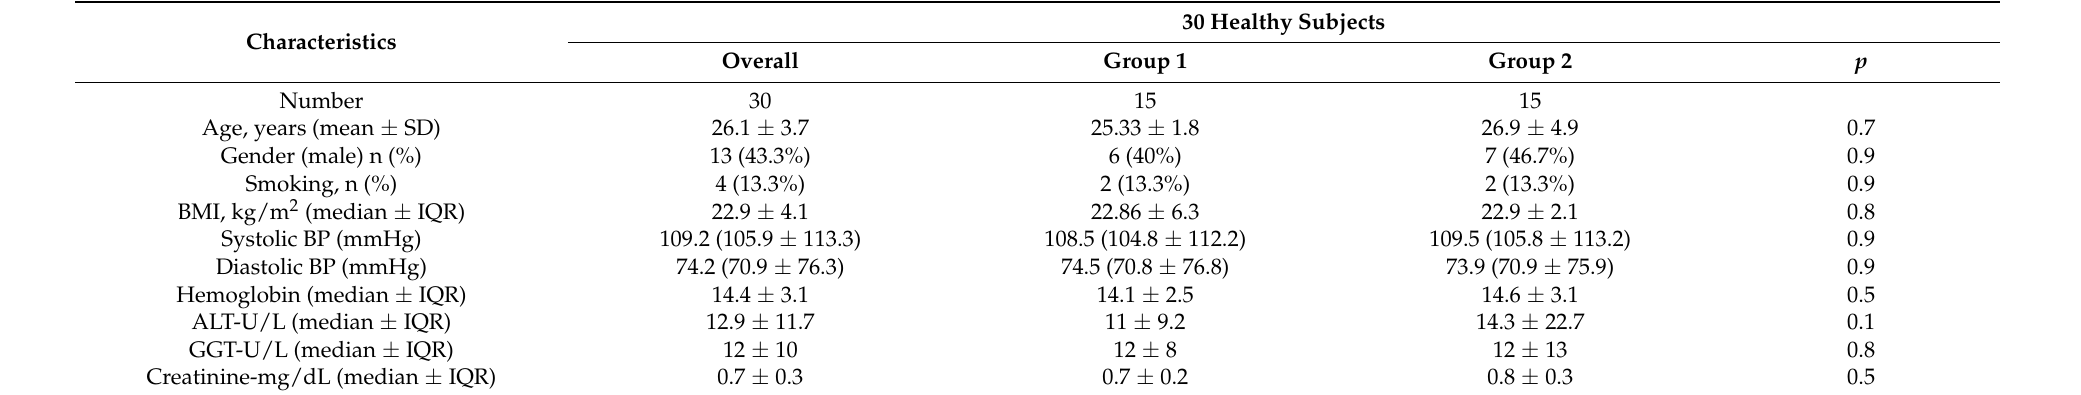
Table 1. Baseline characteristics of the study population.